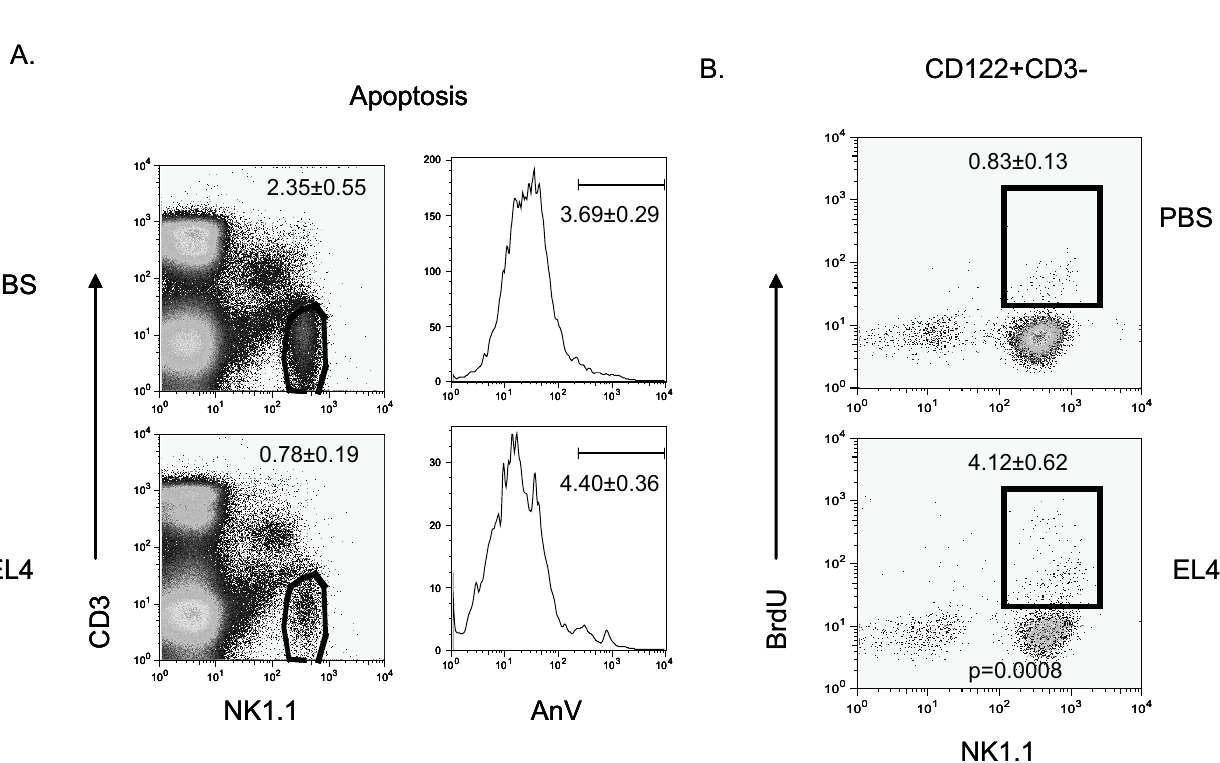
Figure 2. Apoptosis and NK cell proliferation do not account for NK cell depletion. Mice were injected subcutaneously with PBS or 5 6 10 6 EL4 cells. After 3 weeks, control and EL4-bearing mice were sacrificed and splenocytes were stained. A. The percentage of Annexin V + NK1.1 + CD3 2 cells was used to determine the level of NK cell apoptosis. B. Three hours prior to euthanasia control and tumor-bearing mice were injected with BrdU. Splenic NK cells were then stained for intracellular BrdU. The splenic NK cell population was gated on CD122 + CD3 2 cells. Data shown were means and SEM, involving 5 mice per group.